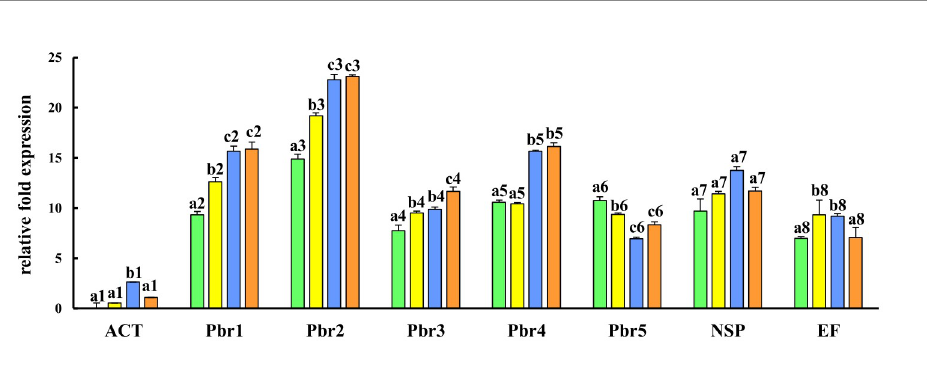
Fig 6. Differential gene expression of some putative serine proteases in P . brassicae larvae fed on different diets. Relative fold gene expression of gut serine proteases (Pbr1-5) in larvae reared on the following diets: CF-CF (green bars), CF-GN (yellow bars), GN-CF (blue bars) and GN-GN (orange bars). NSP refers to nsp gene (accession KC570465) while EF refers to EF1- α gene (accession HQ693843). Data were normalized with respect to levels of actin ( act) gene (accession BBA78421) transcripts detected in larvae fed CF-CF diets. Bars depict mean ± SE. Significant differences (at p � 0.05, Tukey’s HSD test) are denoted by different letters.